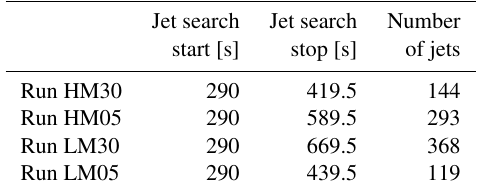
Table 2. Jets in the four runs listed in Table 1. The first (second) column is the start (stop) time of the simulation when the jet search began (ended). The third column gives the number of jets found in each